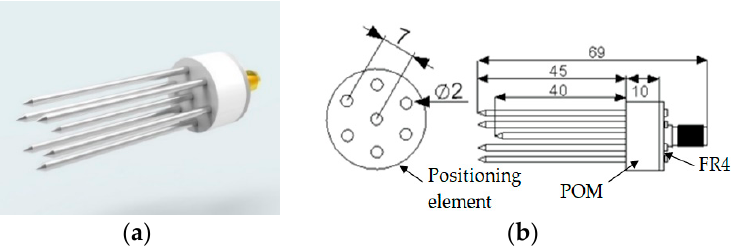
Figure 1. Tested seven-rod probe and the elements of the measurement setup; ( a ) a probe, ( b ) respective dimensions of the probe (dimensions in